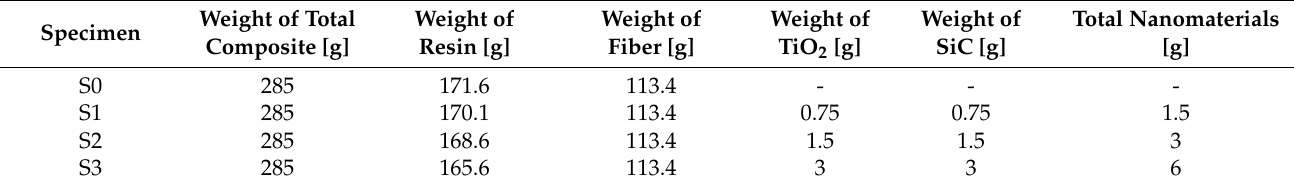
Table 5. Weight of materials used.